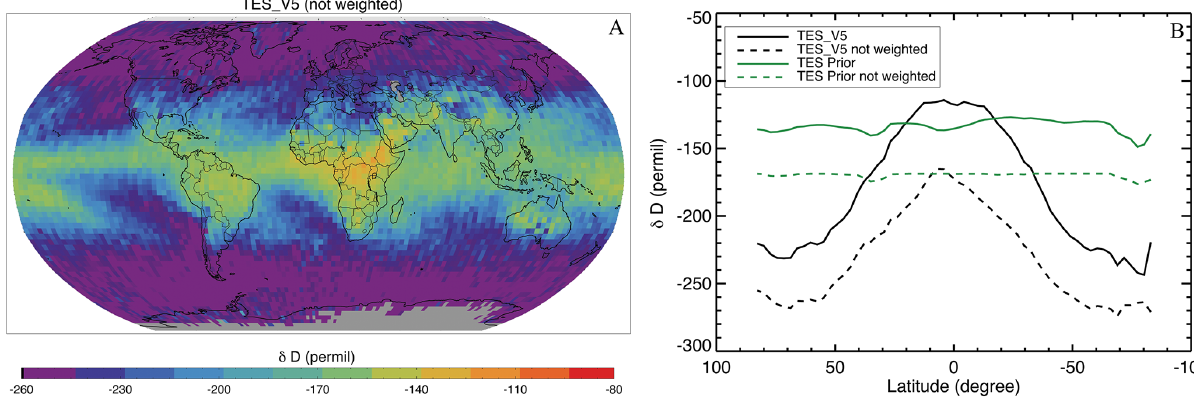
Figure 8. (a) Arithmetically averaged δ D product from TES V5 for the vertical region 900–425hPa; (b) annually averaged latitude distribution of the H 2 O-weighted (solid lines) and arithmetically averaged (dashed lines) δ D value (900–425hPa) from TES V5 and the respective values for the prior